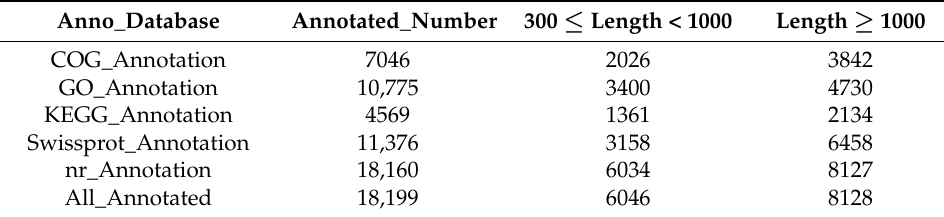
Table 2. All unigenes of M. roridum transcriptome annotated in different databases.